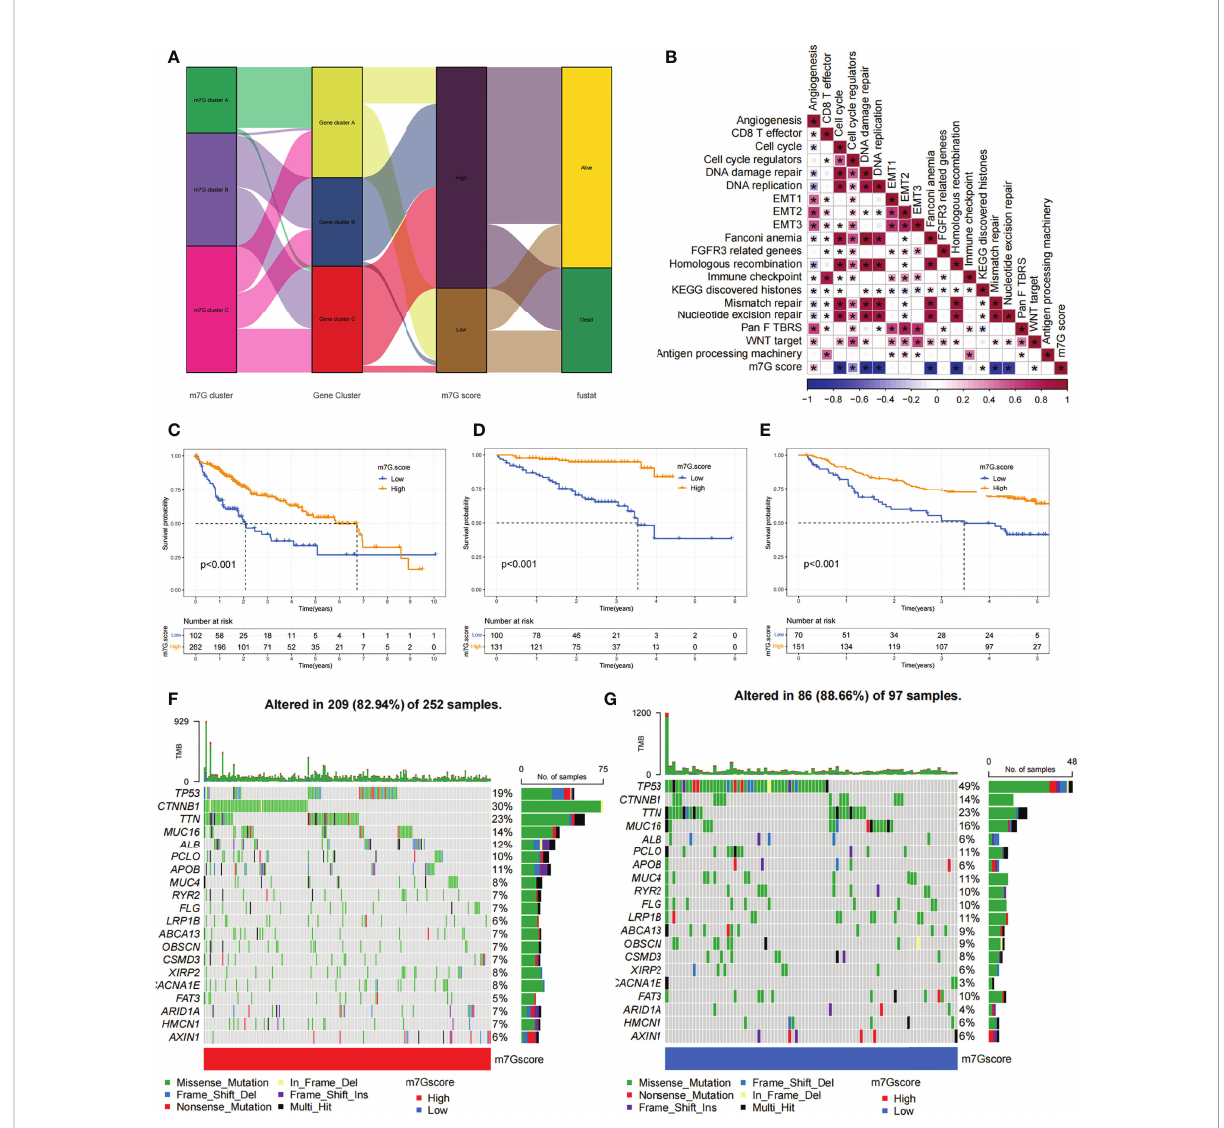
FIGURE 7 Construction of the m 7 G score and exploration of the relevance of its clinical features. (A) Alluvial plots showed changes in m 7 G clusters, gene clusters, m 7 G score and patient survival status. (B) Associations between m 7 G scores and certain biogenetic markers were analyzed. Positive associations were colored in red and negative associations were colored in blue. (C) Survival curves for the high and low m 7 G score patient subgroups in TCGA-LIHC cohort. P< 0. 001. (D) Survival curves for high and low m 7 G score subgroups of patients in LIRI-JP cohort. P< 0. 001. (E) Survival curves for high and low m 7 G score subgroups of patients in GSE14520 cohort. P< 0. 001. (F, G) The mutation status of SMGs in TCGA-LIHC cohort was divided into high (F) and low (G) m 7 G score subgroups. Each column represents single patient. The top bar shows the tumor mutation burden(TMB), and the numbers on the right indicates the mutation frequency of individual genes. Asterisks represent statistical p-values (*P < 0.